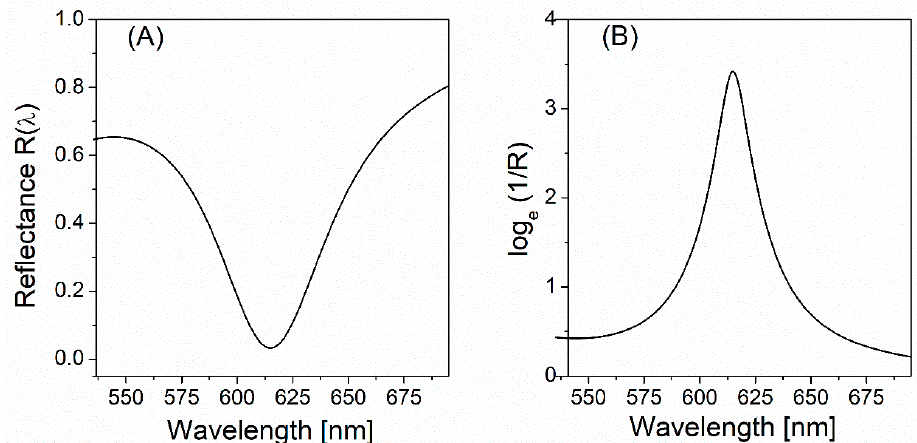
Figure 2. ( A ) The reflectance R ( λ ) ≡ | r ( λ ) | 2 calculated by a field transfer matrix-based formula (Equation (1)), assuming the Kretschmann–Raether configuration where SPP is excited at the interface between the 50 nm-thick Au film and air. The incident angle ( θ in ) is 43.85 ◦ . The reflection dip occurs at a wavelength of about 615 nm. ( B ) The natural logarithm of 1/ R ( λ ) where R ( λ ) is given by ( A